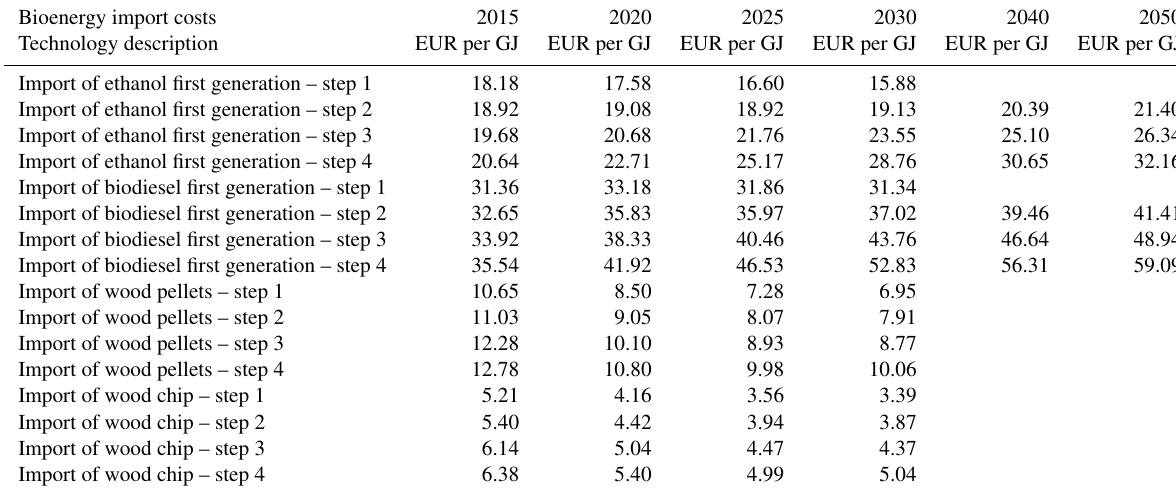
Table A2. Import bioenergy commodity